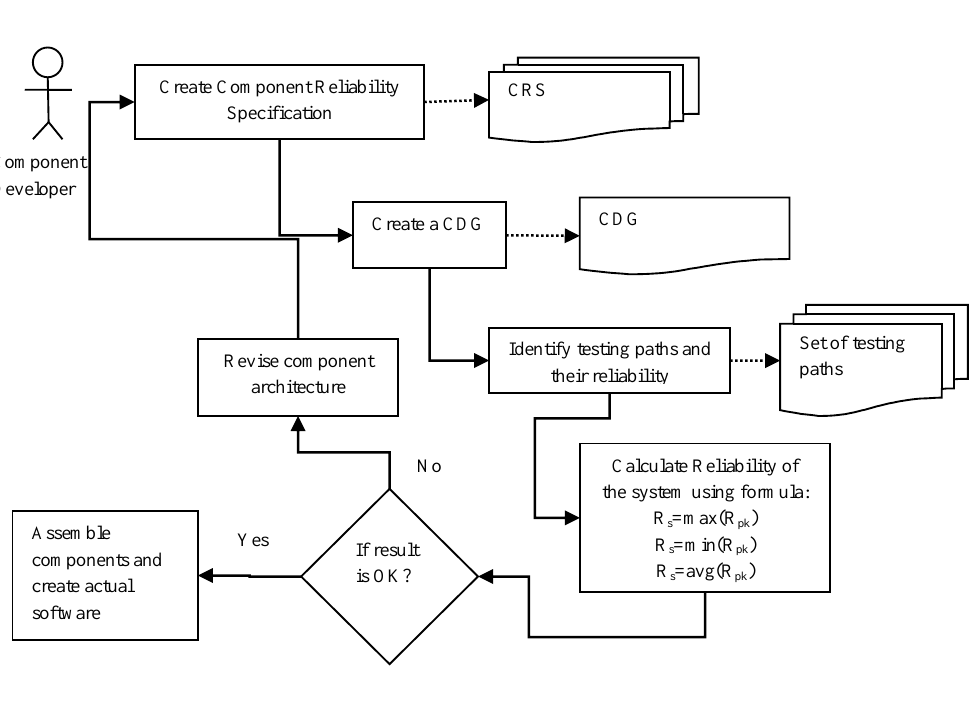
Figure 1. Proposed